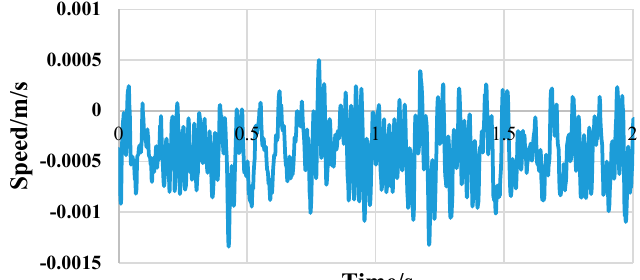
Figure 3. Vibration time － domain diagram.